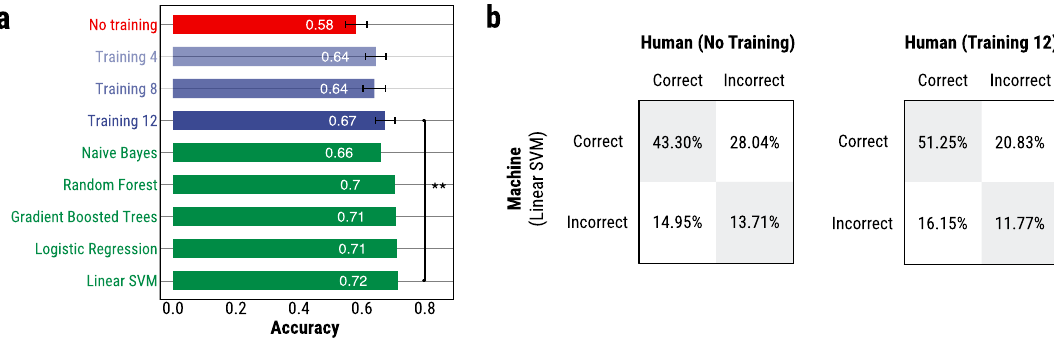
Figure 7. Results of Study 2. (a) Comparison between the accuracy of human (across the four different conditions) and machine learning predictions on a random sample of 1,000 photos. The machine learning algorithms were trained on the remaining 42,113 photos from the full dataset. The error bars on the human accuracy represent 95% confidence intervals. (b) Comparison of the correctness of the predictions of the most accurate machine learning model (Linear SVM) and the predictions of the untrained (left) and best trained (right) participants. In both cases, there is a significant proportion of photos (42.99% and 36.98%, respectively) where only the human or only the machine predictions are correct. (** p < 0.01